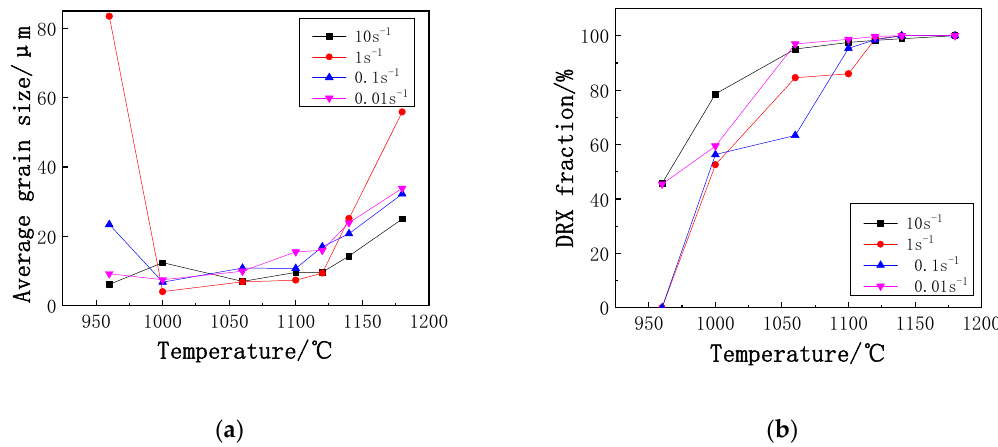
Figure 12. The average grain size ( a ) and DRX fraction ( b ) of the specimens deformed at different